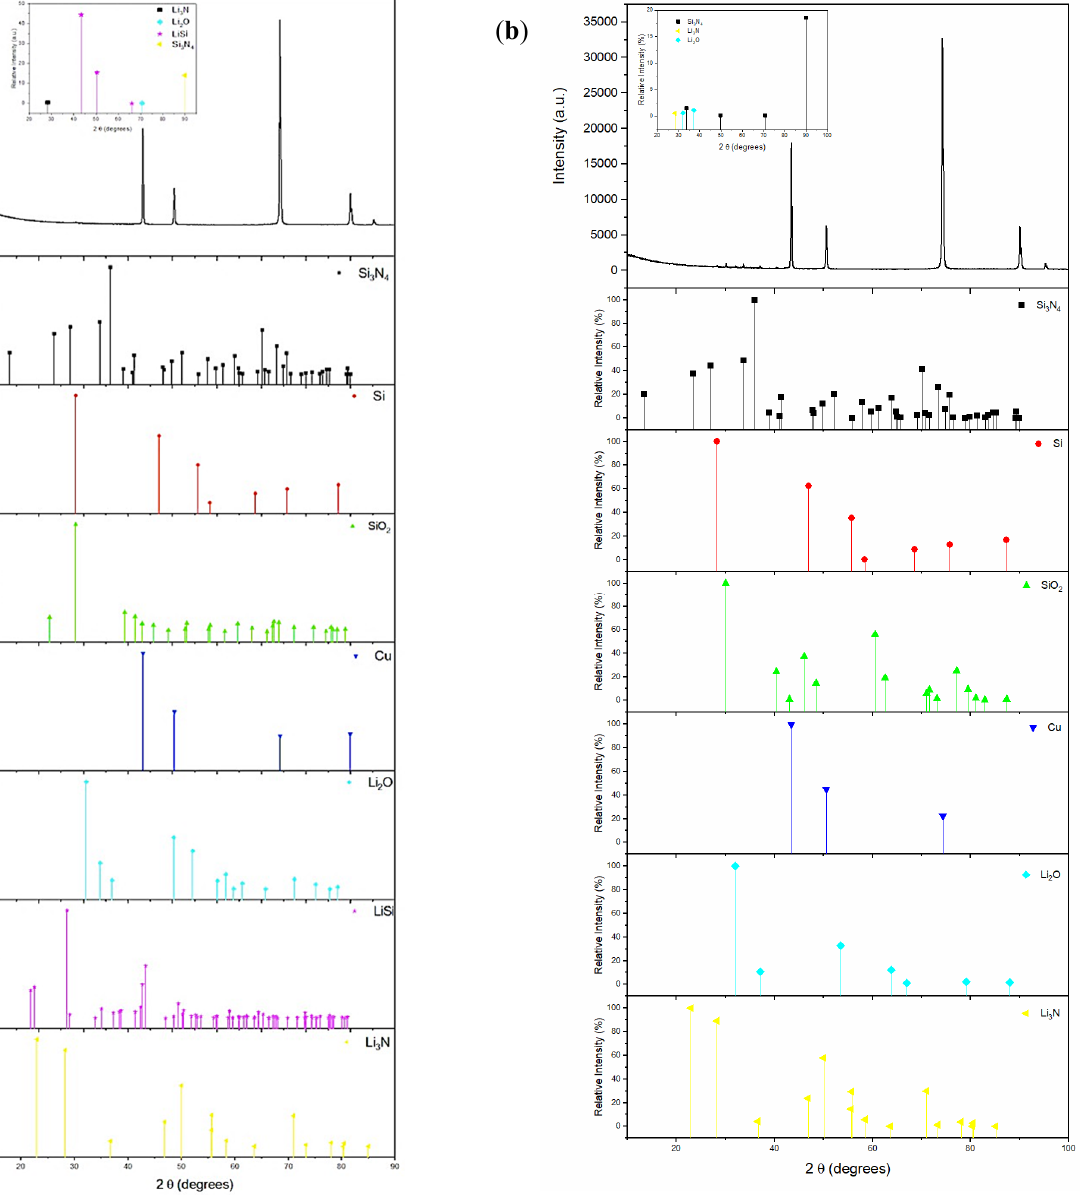
Figure 14. XRD spectra of Si 3 N 4 @Si@Cu anode material ( a ) after lithiation to 0.05 V and ( b ) after delithiation to 1.20 V in a half cell vs. Li + /Li. The standard XRD spectra of Si 3 N 4 (ICDD:98-064-4680), Si (ICDD:98-042-6975), SiO 2 (ICDD:98-005-1701), Cu (ICDD:98-062-7117), Li 2 O (ICDD:98-018-2028), LiSi (ICDD:98-008-3826), and Li 3 N(ICDD:98-003-478) are given for comparison.